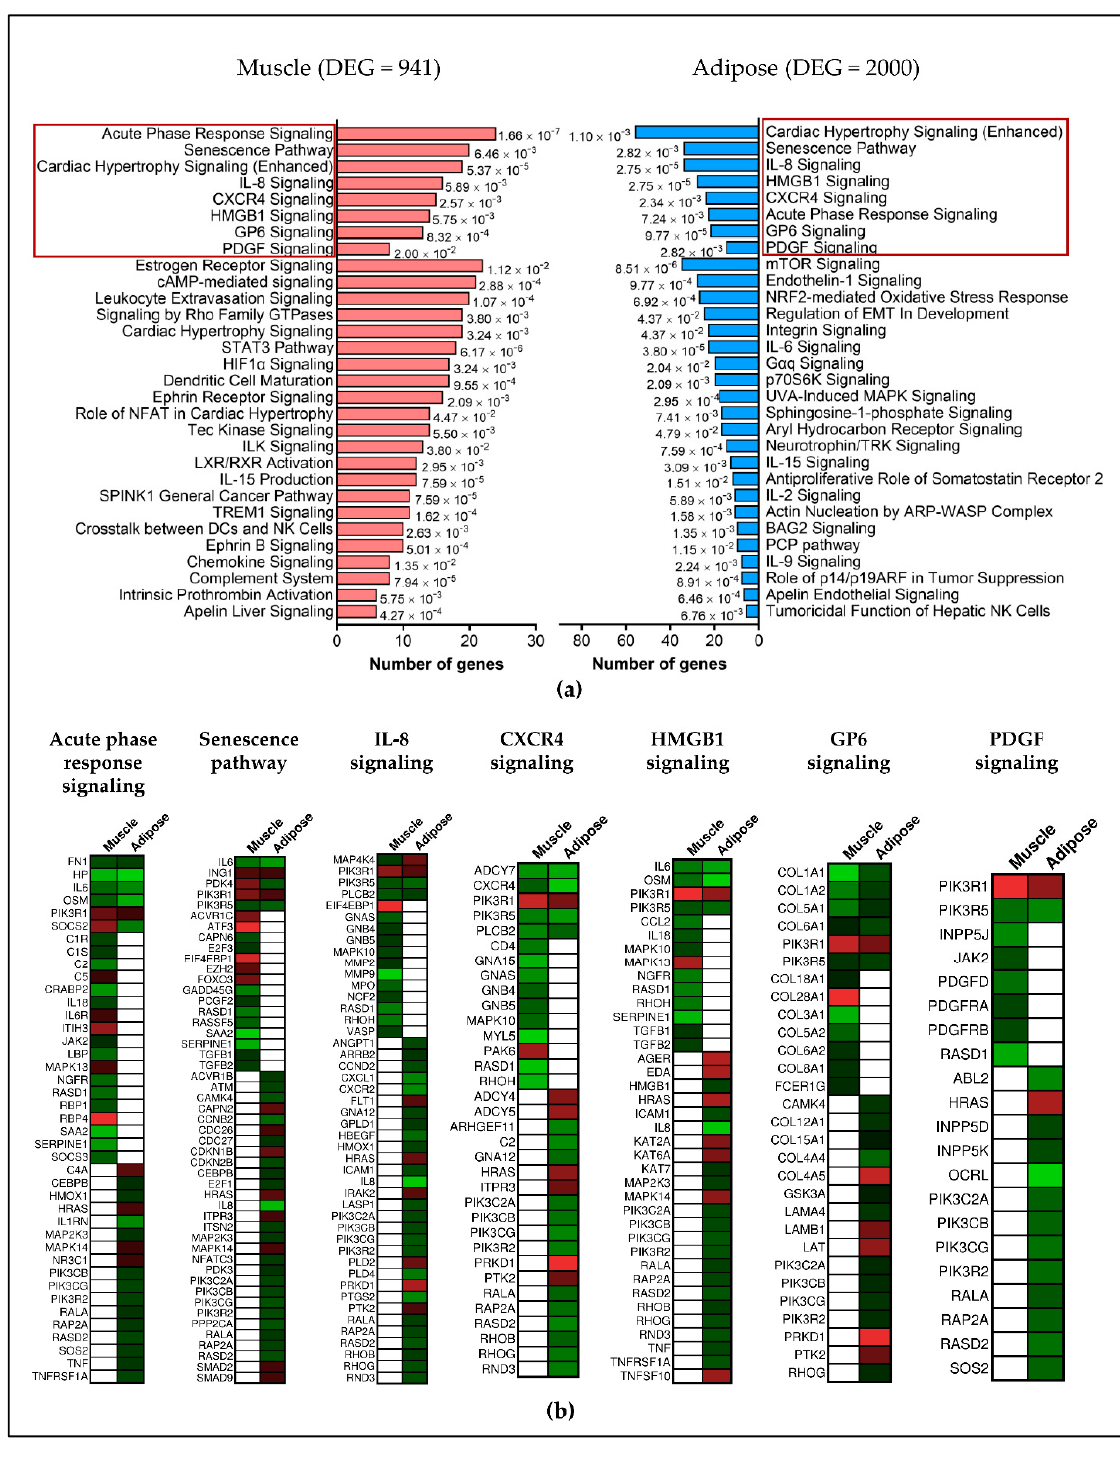
Figure 4. Canonical pathways for muscle and adipose. ( a ) The top pathways highlighted in red indicates the common pathways between muscle and adipose. The unique pathways are also represented in muscle and adipose; ( b ) although there are common pathways between muscle and adipose, the genes involved in activating or inhibiting those pathways are predominantly different, indicating a tissue specific gene expression.